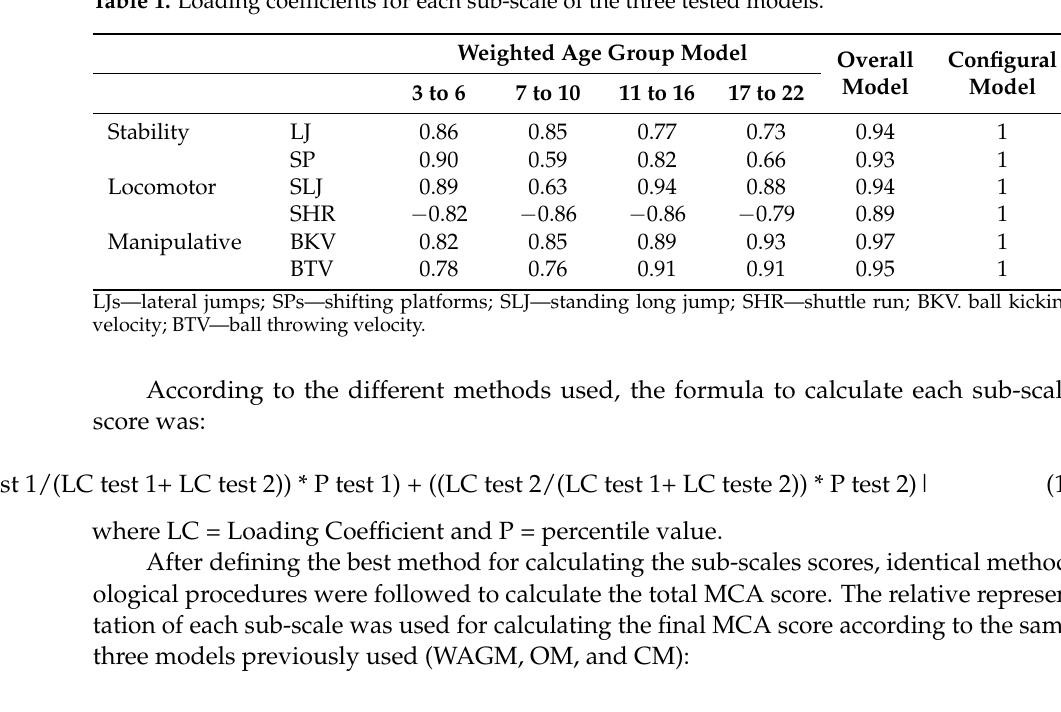
Table 1. Loading coefficients for each sub-scale of the three tested